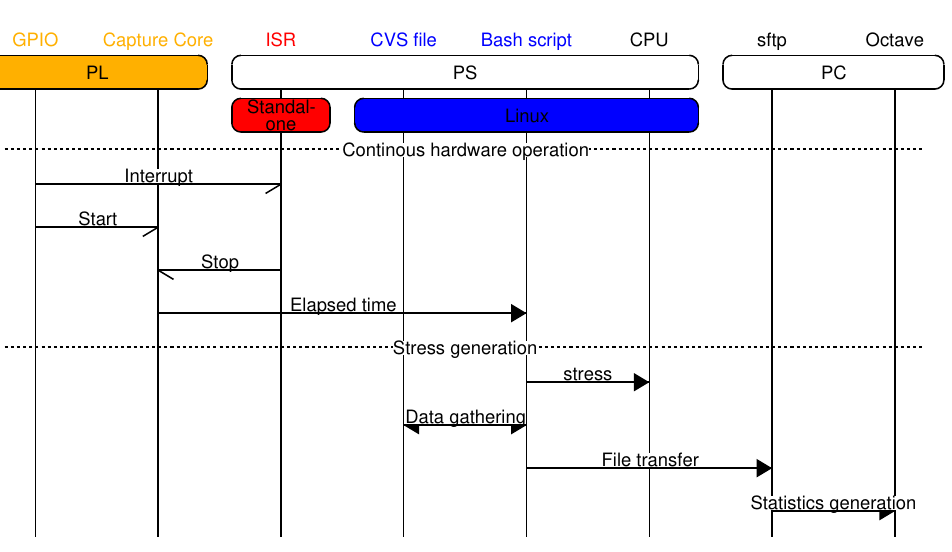
Figure 3. General flow. In the PL, the timer is started while the interrupts are generated. The ISR receives the interrupt and stops the timer. The processor also reads the timer value and generates all the files for the statistical evaluation. At the same time, the processor also stresses the memory and CPU. In an external PC, all the data are gathered and